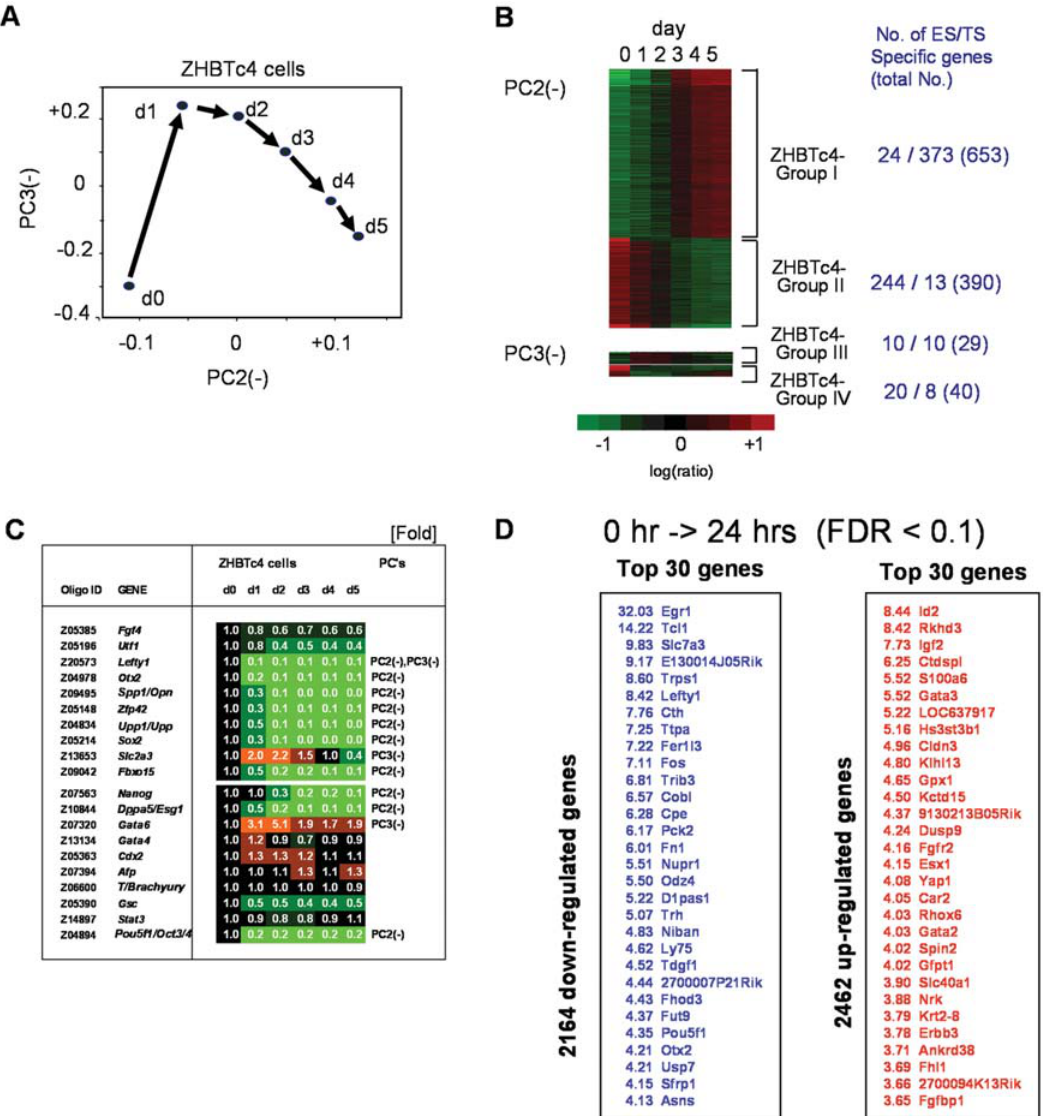
Figure 2. Principal component analysis (PCA) and the expression pattern heatmap of known target genes for Oct3/4 and related genes. (A) 2D-views of PCA for 2,757 genes that were identified as significantly differentially expressed during this time course. (B) The expression pattern and ES/TS specificity of each component of PCA was classified into 4 groups (Group I , Group IV). (C) Known target genes for Oct3/4 and related genes. (D) Top 30 up- and down-regulated genes from 0 h v 24